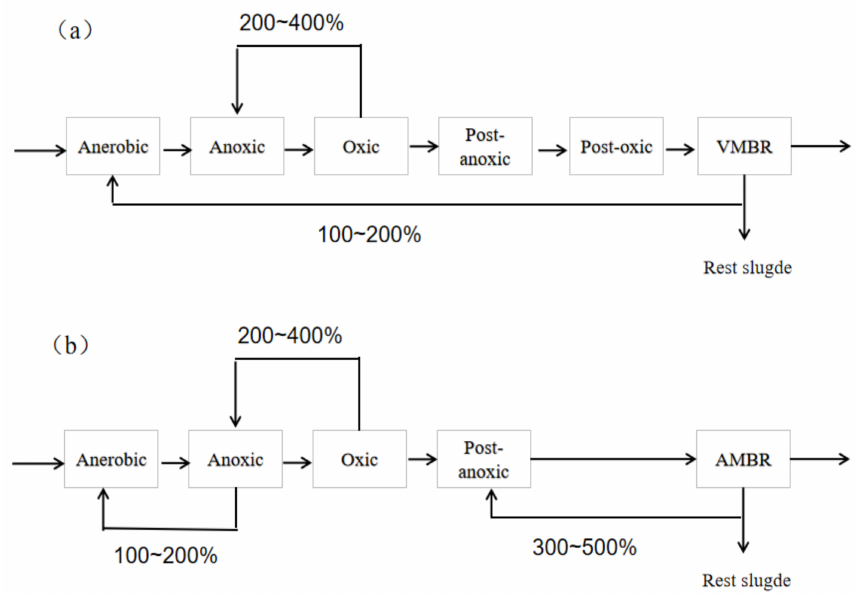
Figure 8. Technology process of ( a ) VMBR and ( b )